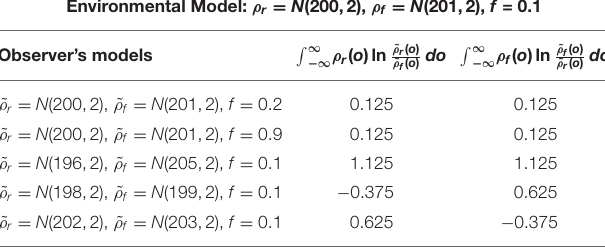
TABLE 2 | Descriptions of the observer’s assumptions for each trial, with the true environmental conditions given in Figure 5